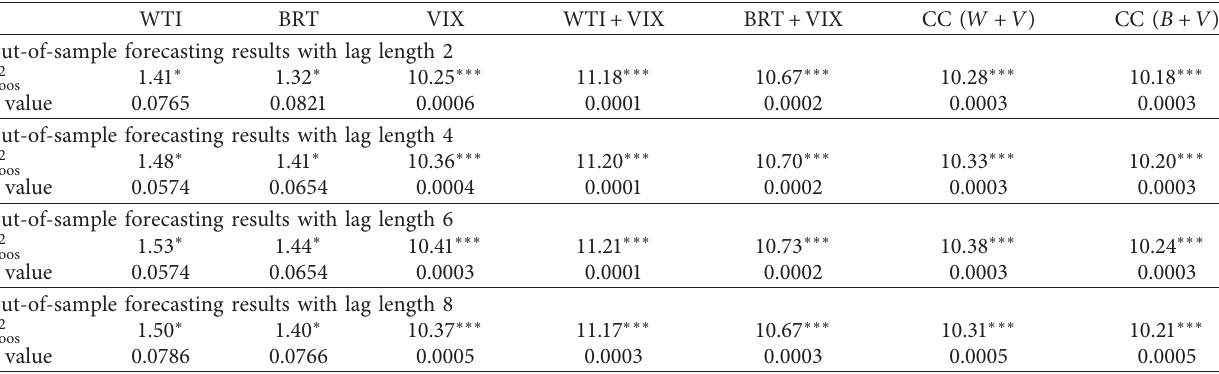
Table 6: Out-of-sample forecasting results with different lag